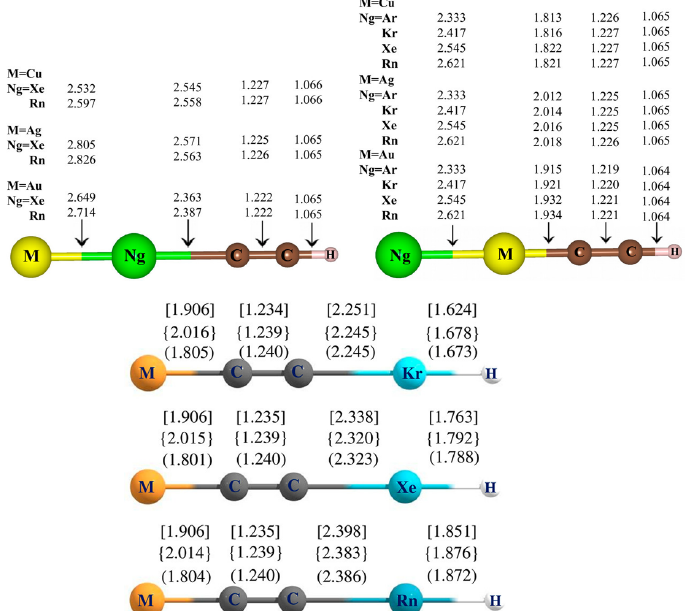
Figure 3. Optimized geometries of the insertion MNgCCH, non-insertion NgMCCH, and MCCNgH complexes, along with the respective bond distances (in Å) for the concerned bonds. The values within the parenthesis, braces, and square brackets are computed for Cu, Ag, and Au, respectively. [Reprinted from Refs. [86 , 87] with permission from American Chemical Society. © 2017 and © 2018, American Chemical Society, respectively] .